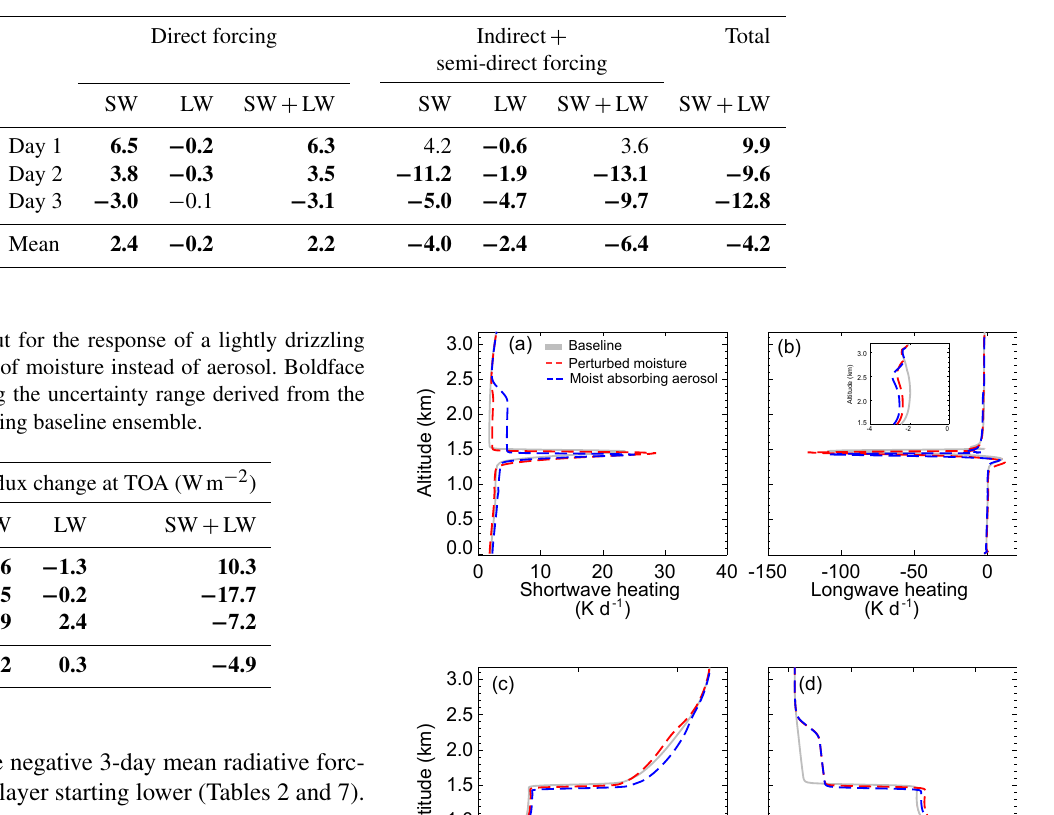
Table 7. As in Table 2 but with the absorbing aerosol layer initially located 400m higher. Boldface indicates results exceeding the uncertainty range derived from the spread of the lightly drizzling baseline ensemble.